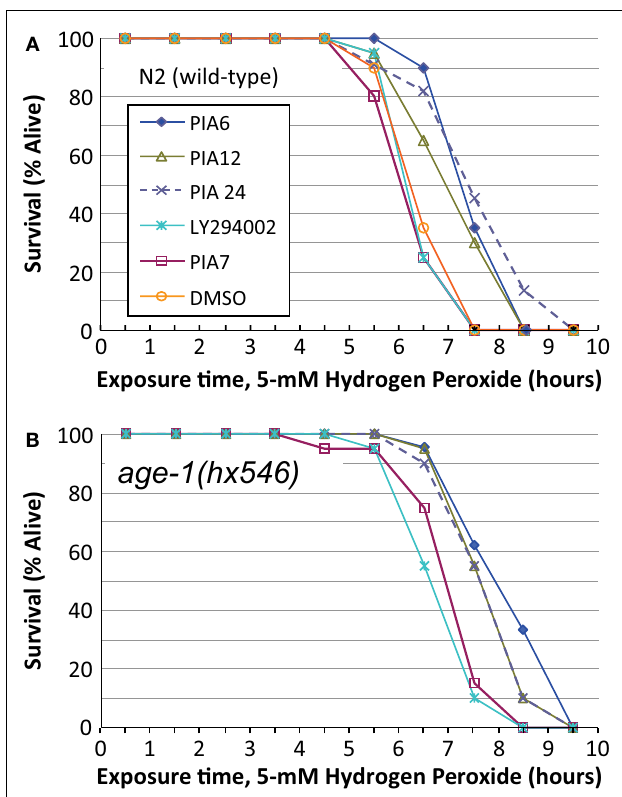
FIGURE 6 | Survival time during exposure to a toxic level of hydrogen peroxide, after development and growth in the presence of PIAs or LY294002. Adult worms (day 2–3 after the L4/adult molt) of strain N2DRM [ (A) , wild-type] or age-1 ( hx546 ) [ (B) , a moderately long-lived age-1 mutant] were maintained from hatching on 1 µ M of LY294002 (a widely used inhibitor of class-I PI3K); PIA6, PIA12, or PIA24 (active PIP 3 analogs); PIA7 (inactive control analog); or their common solvent, DMSO (added in the amount transferred with the inhibitors).Worms at adult day 3 were transferred to liquid medium without bacteria, containing 5mM hydrogen peroxide, and were then monitored hourly for survival as described in the Figure 5